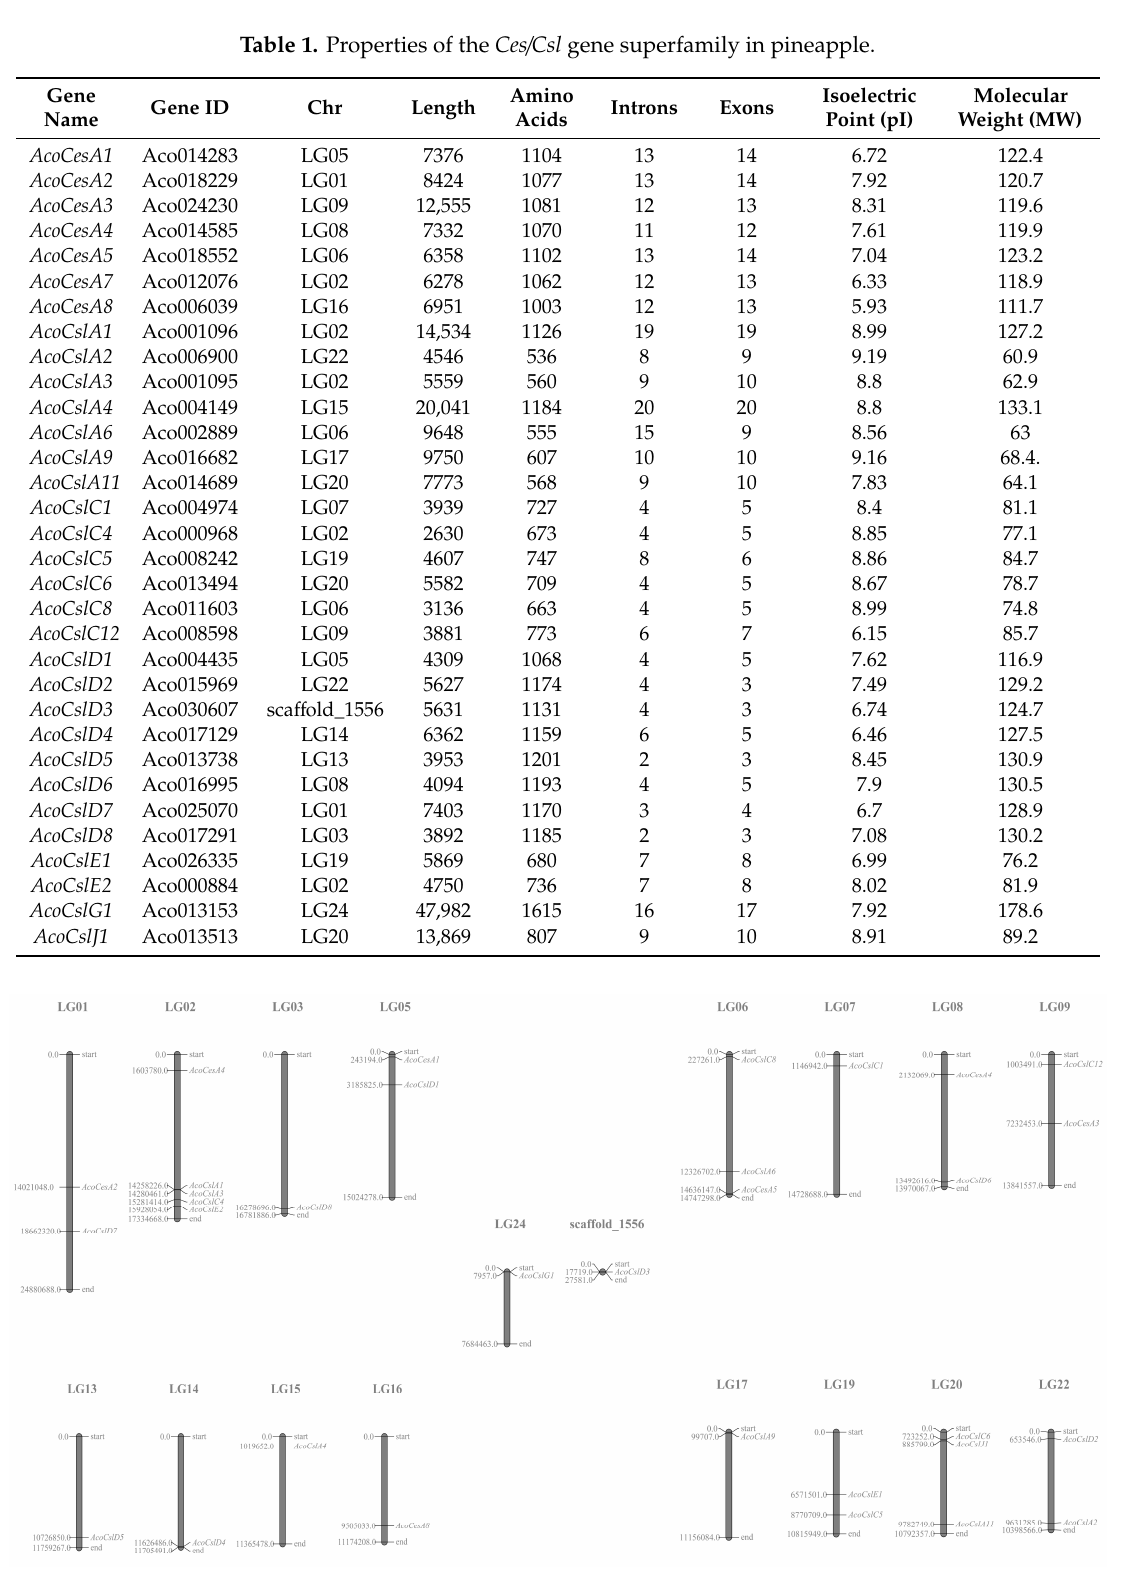
Figure 1. Distribution of AcoCes / Csl genes on the pineapple genome. The gene start points are shown on the chromosome. Thirty-two Ces / Csl genes of pineapple were mapped to di ff erent chromosomes using MapChart. Only those chromosomes bearing AcoCes / Csl are represented. The prefix ‘Aco’ indicates Ananas comosus .